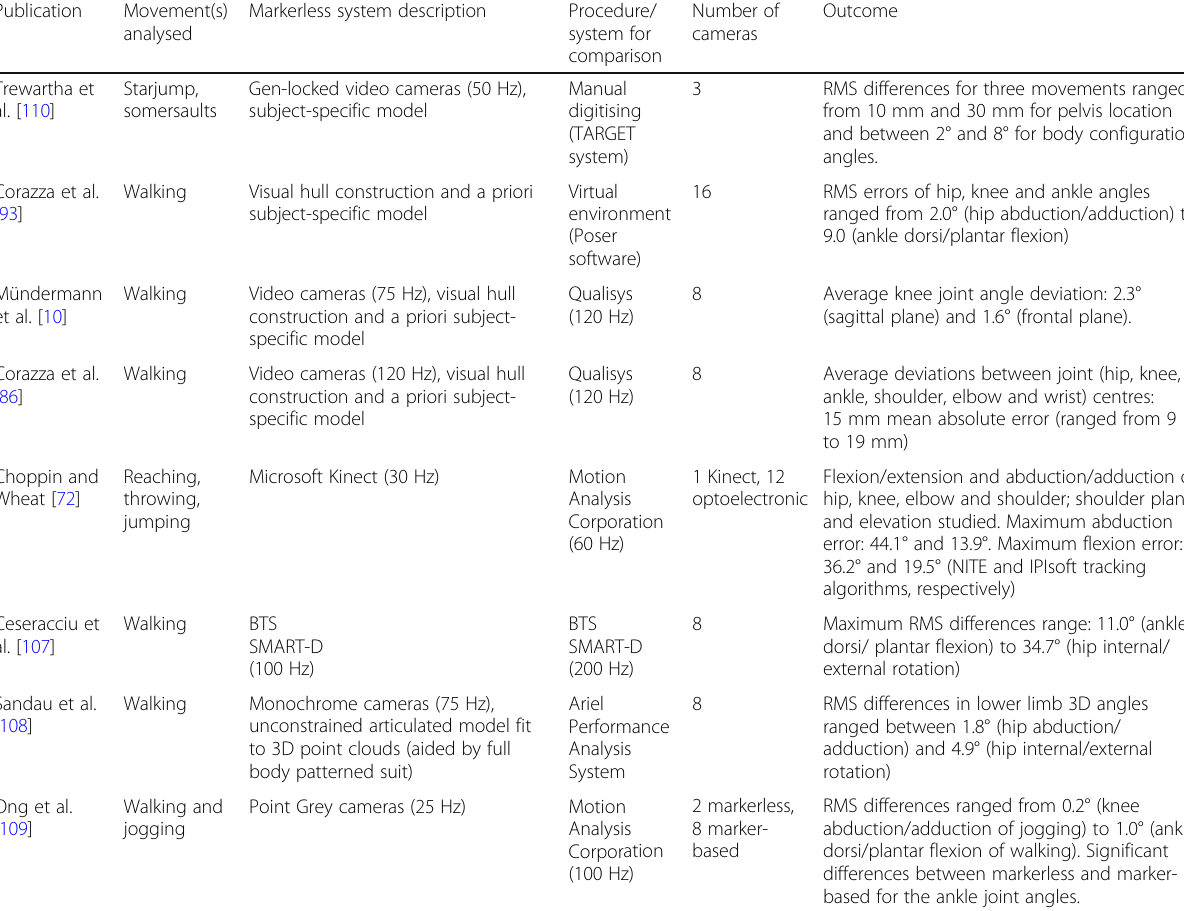
Table 2 Overview of studies comparing markerless with conventional motion analysis